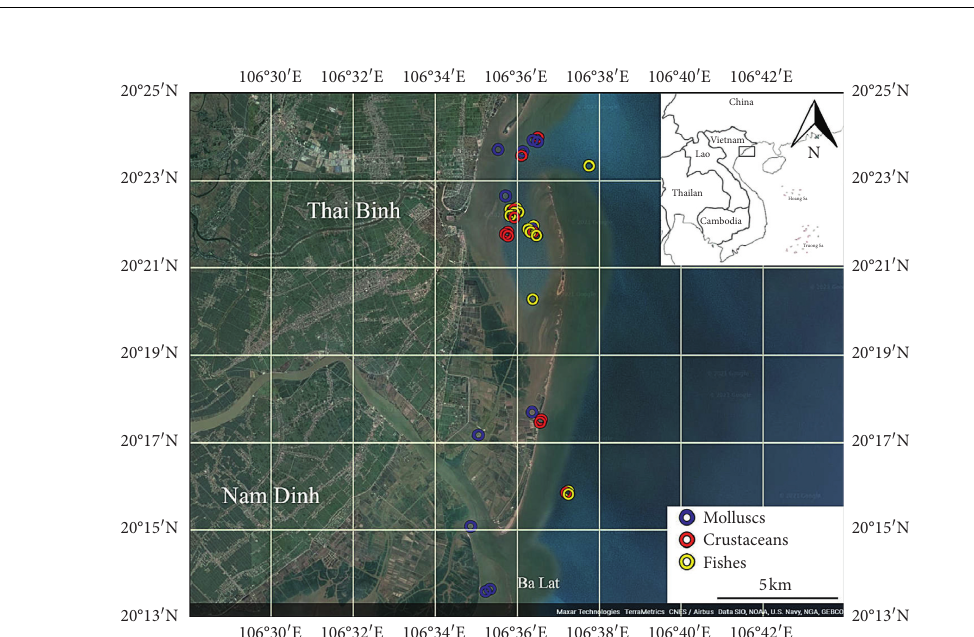
Figure 1: The Ba Lat estuary of the Red River, the coastal zone of the Thai Binh and Nam Dinh Procedure [22], indicating the absence of a significant from standard stock solution (Inorganic Venture, USA) to evaluate the stability of the ICP-MS system. The percent recovery of the quality control sample (QCS) was within 90–102%, which was acceptable for the levels of the target analytes, according to the Manual on Policies and